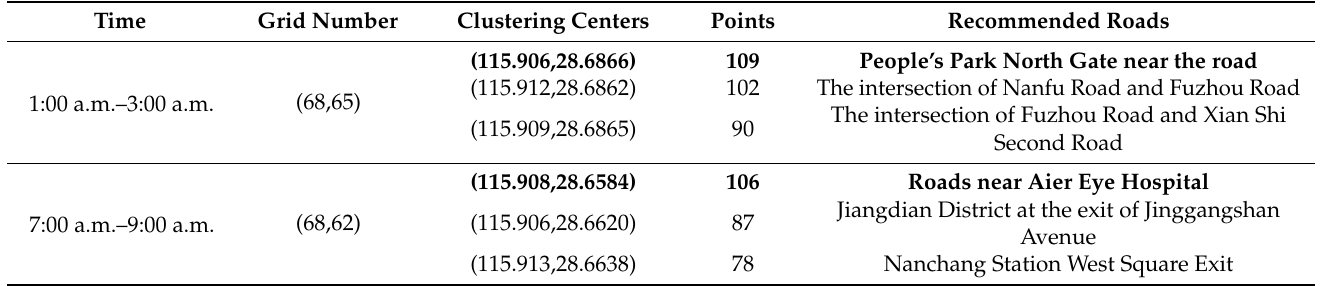
Table 7. Highly ranked grid passenger boarding point clustering centers and recommended roadways (The bolded part is the information about the hotspot section that ranks first in the